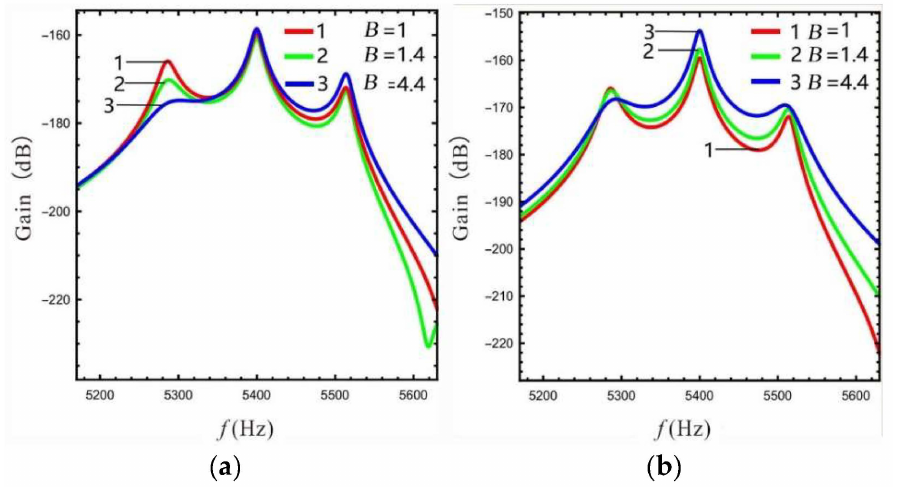
Figure 9. Effect of LR on the gain of the micro-gyro: ( a ) (cid:101) 1 = 0.4, ( b ) (cid:101) 1 = (cid:101) ep (B = 1.4, (cid:101) ep = 0.93; B = 4.4, (cid:101) ep = 0.98 ).